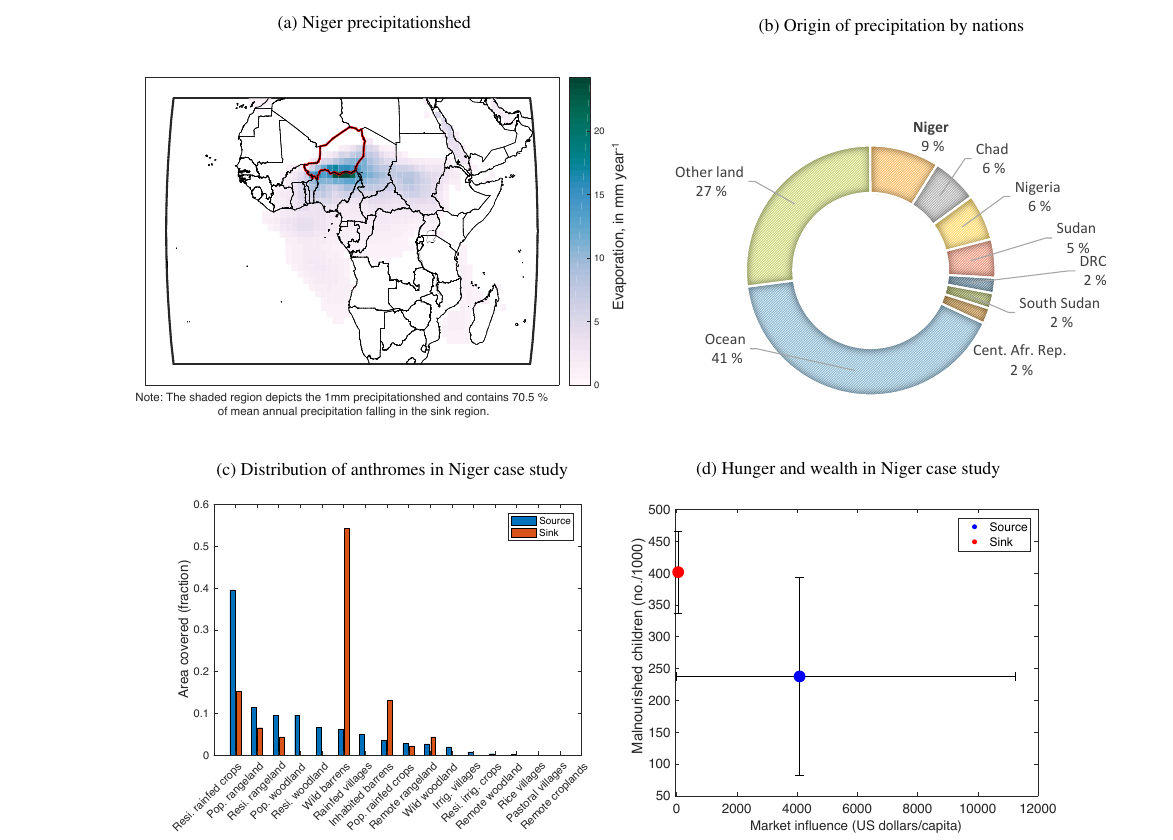
Figure 3. Niger case study including (a) precipitationshed analysis, (b) key source countries, (c) comparison of land-uses between the country and its precipitationshed, and (d) comparison of economic and food security aspects of country and source regions.